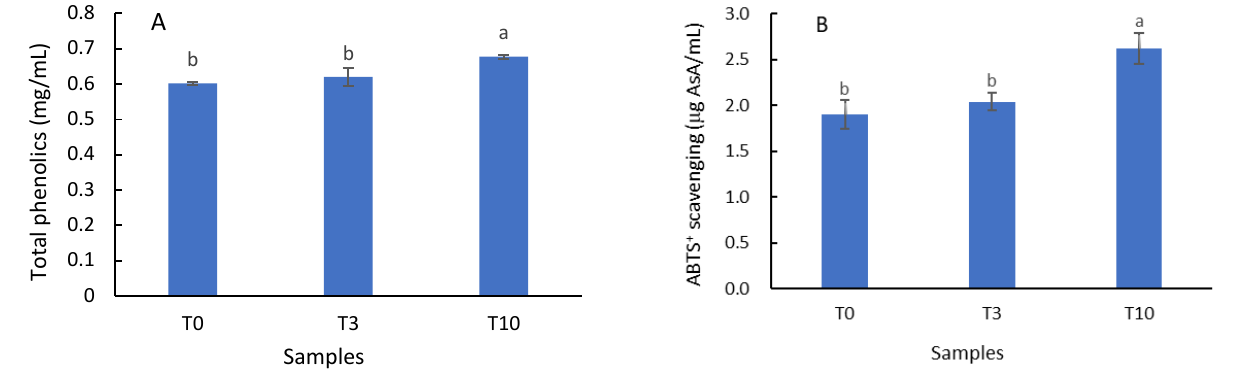
Figure 5. Effects of the addition of D. officinale on the total phenolic content ( A ) and antioxidant activity ( B ) of beer samples. Different letters indicate significant differences between different samples at p < 0.05.